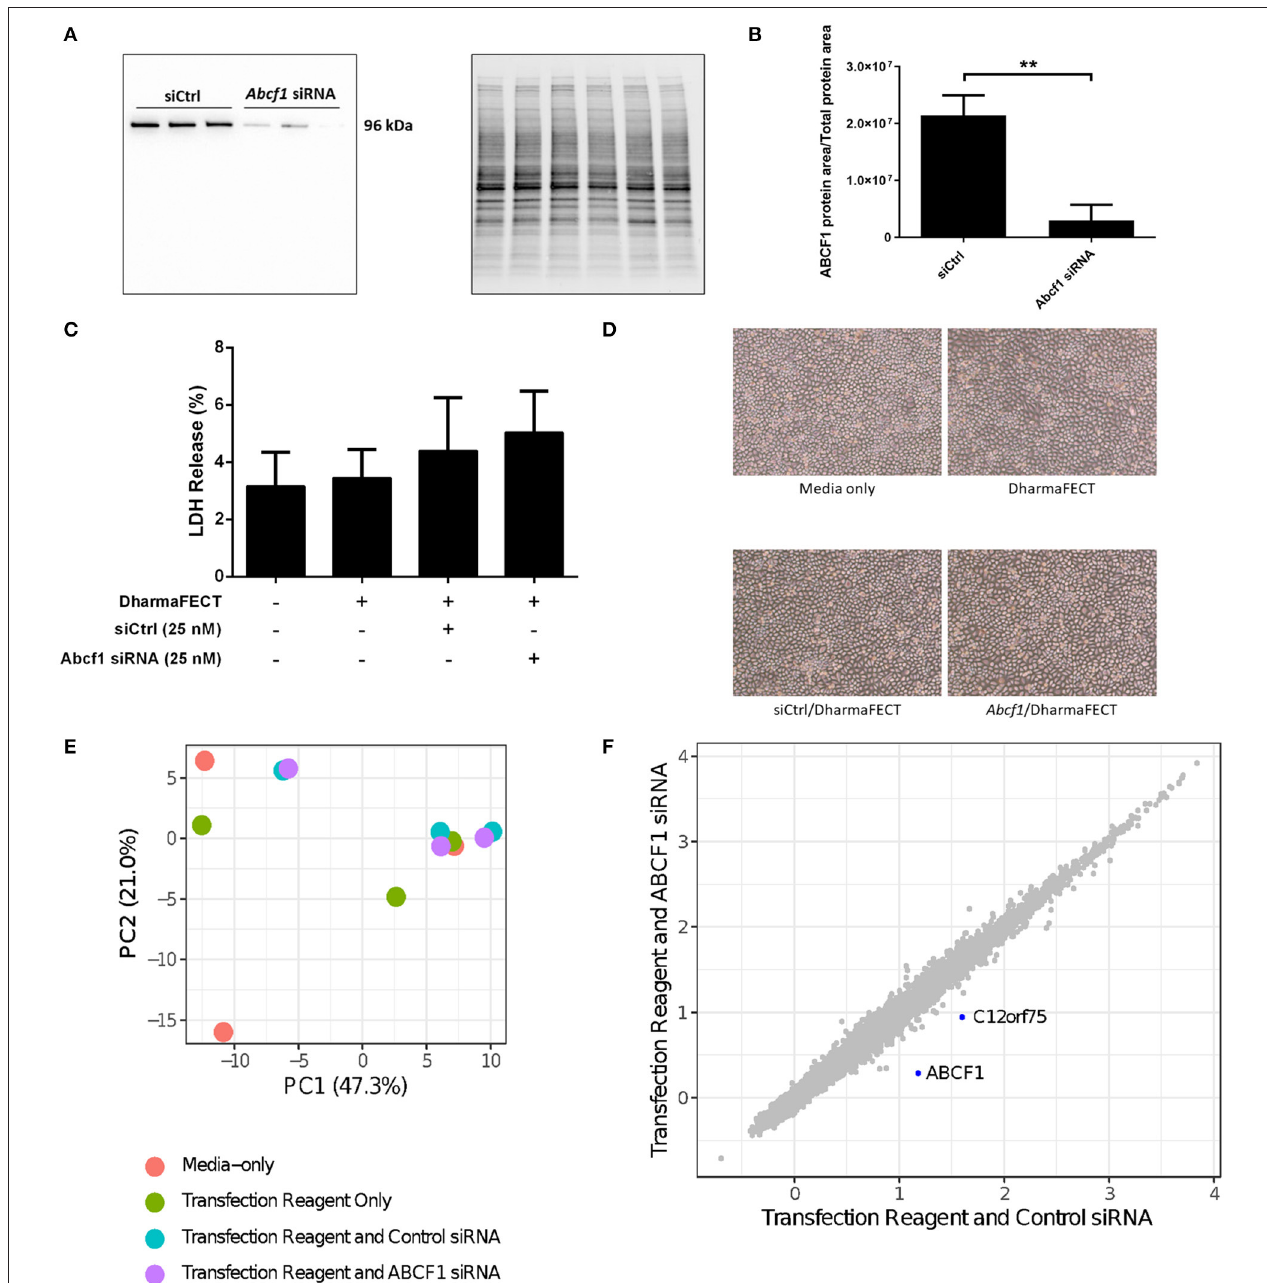
FIGURE 2 | Interrogation of ABCF1 under basal conditions in HBEC-6KT in vitro . (A) Immunoblot confirming siRNA-mediated knockdown of ABCF1 protein expression in HBEC-6KT cells. (B) Quantification of ABCF1 protein expression following siRNA treatment. (C) LDH quantification as a measure of cell viability following siRNA treatment. (D) Phase-contrast microscopy (4X magnification) of HBEC-6KT following siRNA treatment. (E) PCA plot of microarray gene expression profiles of HBEC-6KT cells following siRNA treatment. Red circles (media alone), green circles (transfection reagent only), blue circles (transfection reagent and control siRNA), purple circles (transfection reagent and ABCF1 siRNA). (F) Log2 expression data for transfection reagent with ABCF1 siRNA compared to transfection reagent with control siRNA. Significantly differently expressed genes are in blue and are down-regulated (ABCF1 and C12orf75). All studies n = 3. ** p < 0.01.